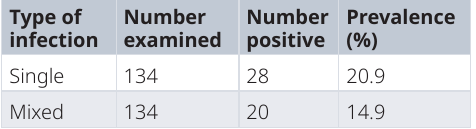
Table 4. Prevalence of intestinal parasite according to type of infection.